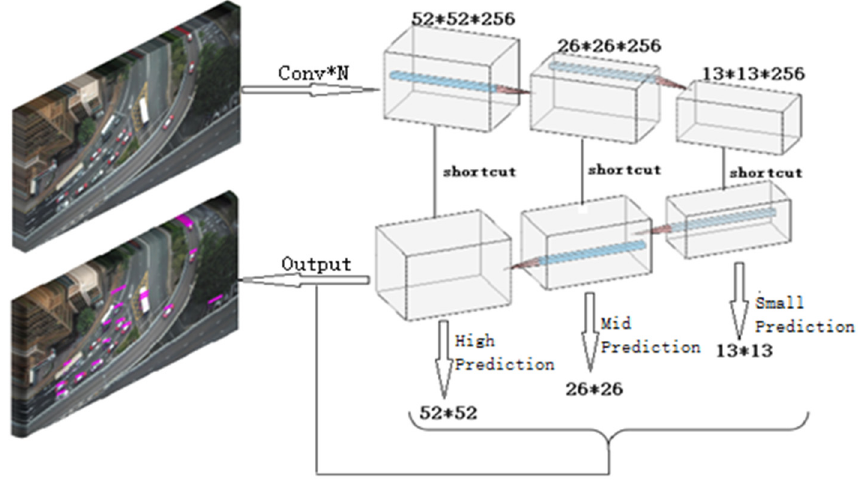
Figure 3. Image feature pyramid prediction structure.